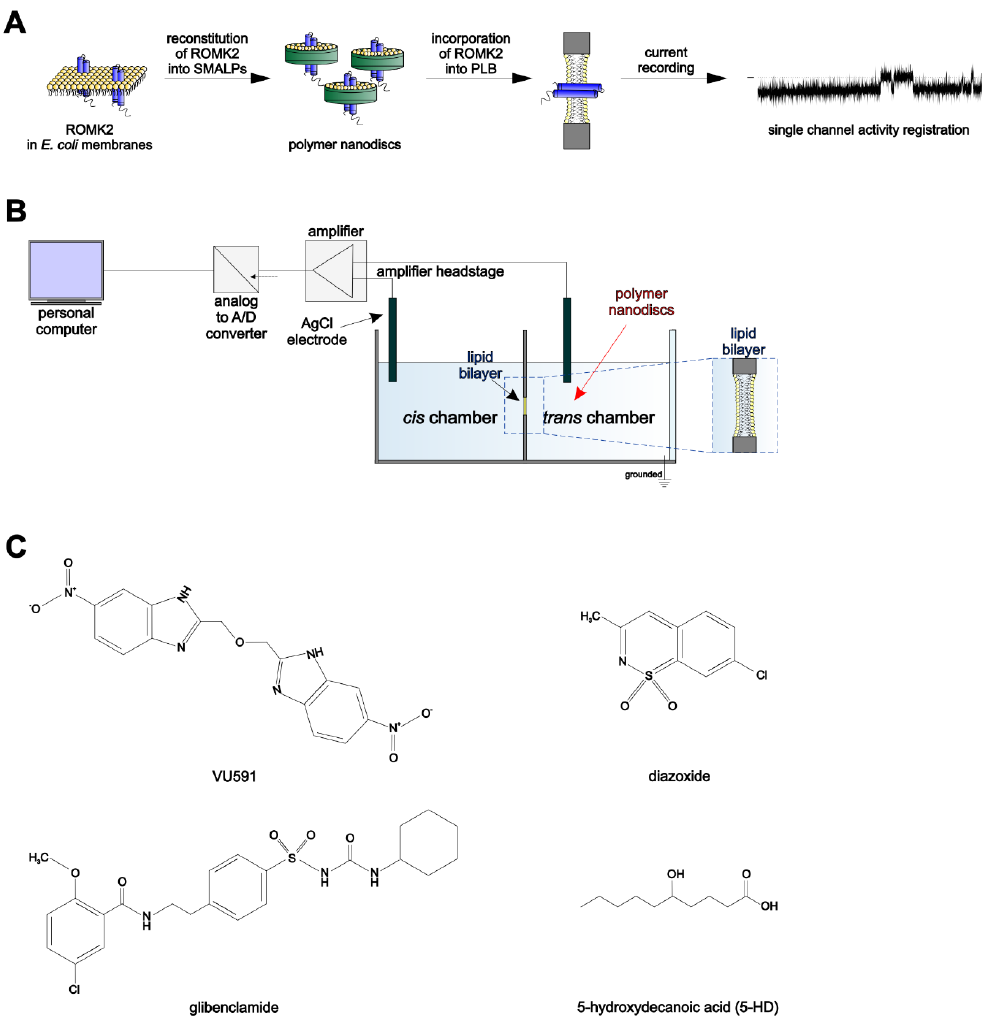
Figure 1. ( A ) Schematic representation of the experiment. From left to right: (i) Reconstitution of the ROMK2 channel protein from E. coli membranes into polymer nanodiscs (SMALPs), (ii) Incorporation of ROMK2 from the protein-containing nanodiscs into a planar lipid bilayer, (iii) Recording of single channel activity. ( B ) Diagram of the complete bilayer setup. Experimental data were collected and processed based on the current recorded between two compartments— cis and trans . The trans compartment was composed of a Teflon cup holder with a 250 µ m aperture. Both compartments were connected by agar salt bridges and Ag/AgCl electrodes with an amplifier, an analog-to-digital converter, and a personal computer (PC). The compartments were filled with symmetrical (50/50 mM KCl) or asymmetrical 50/150 mM KCl solutions (cis/trans, respectively). SMALPs containing ROMK2 protein were added to the trans compartment. ( C ) Chemical structures of modulators of mitoK ATP or ROMK2 channels.